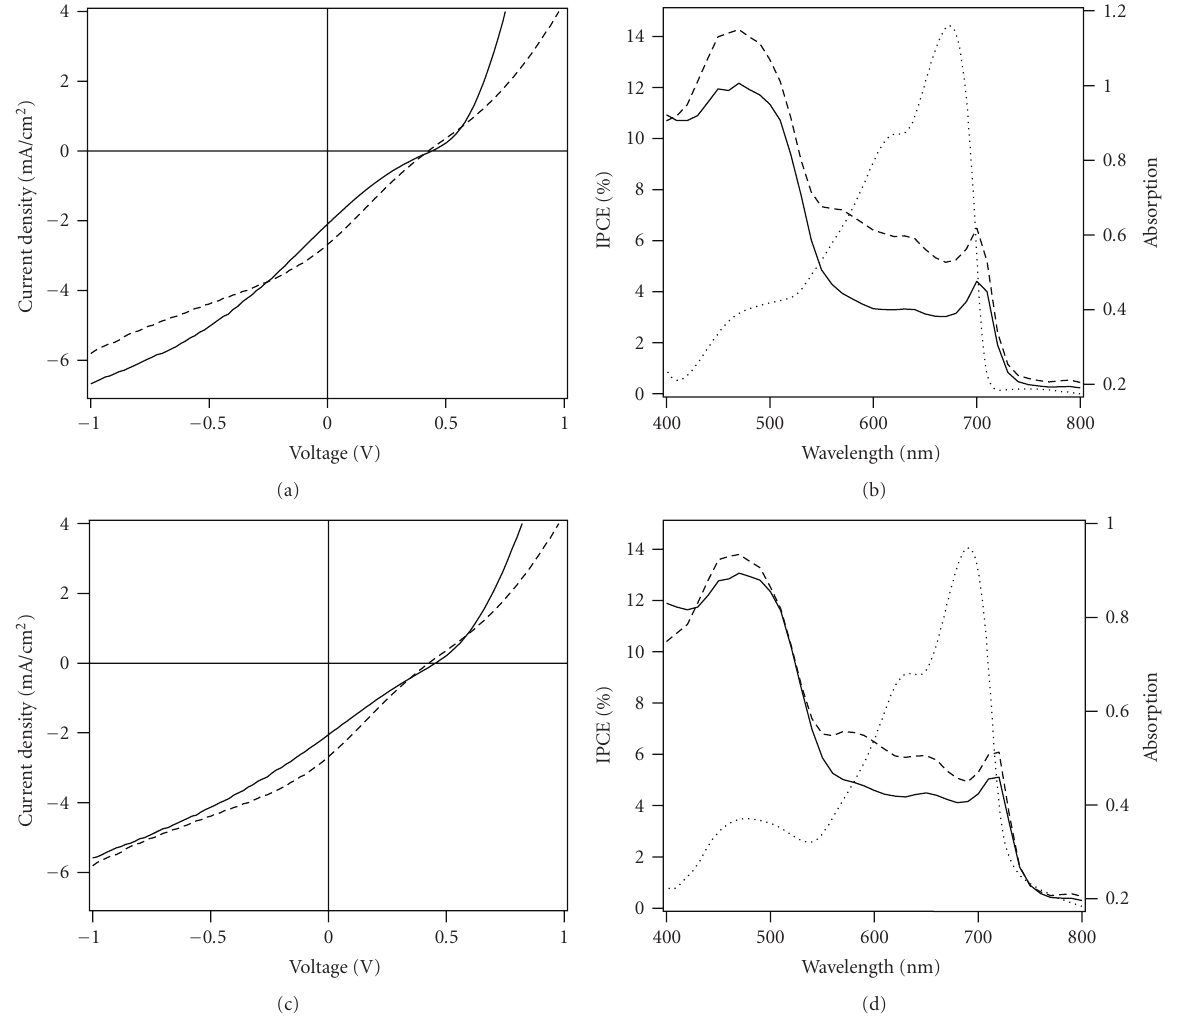
Figure 3: Current-voltage characteristics and IPCE curves of solar cells based on SQ01 ((a) and (b)) and SQ02 ((c) and (d)). The solid cathode, the dashed curves represent the cells using a Ca cathode. The dotted line in (b) and (d) curves represent the cells using an Al/Alq 3 represents the cell absorption. The thickness for SQ01 and SQ02 is 40nm and 35nm,